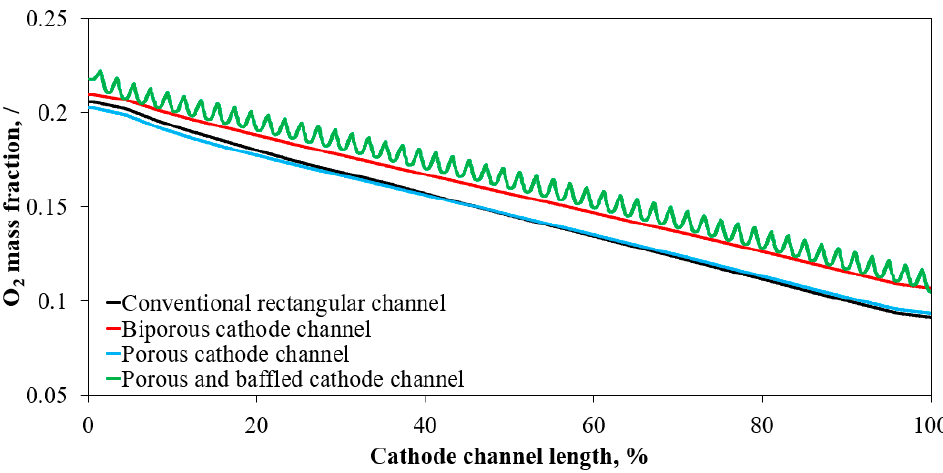
Figure 8. Oxygen mass fraction plot along the cathode substrate mid-line at operating current density of 4.0 A · cm − 2 .